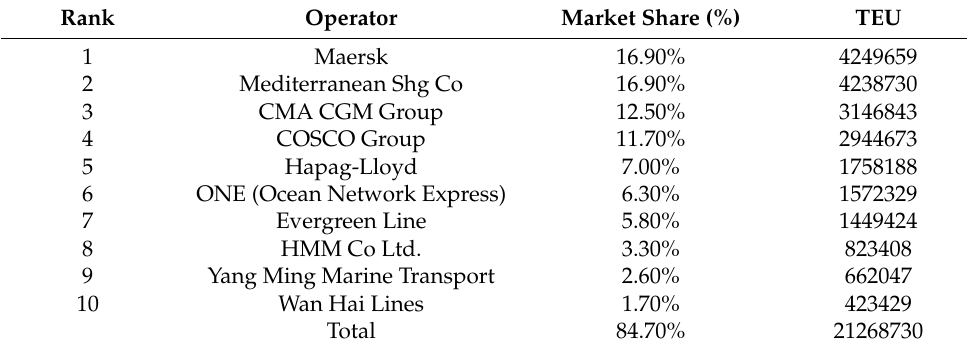
Table 1. Top 10 shipping lines (market share and total operated TEU capacity) as